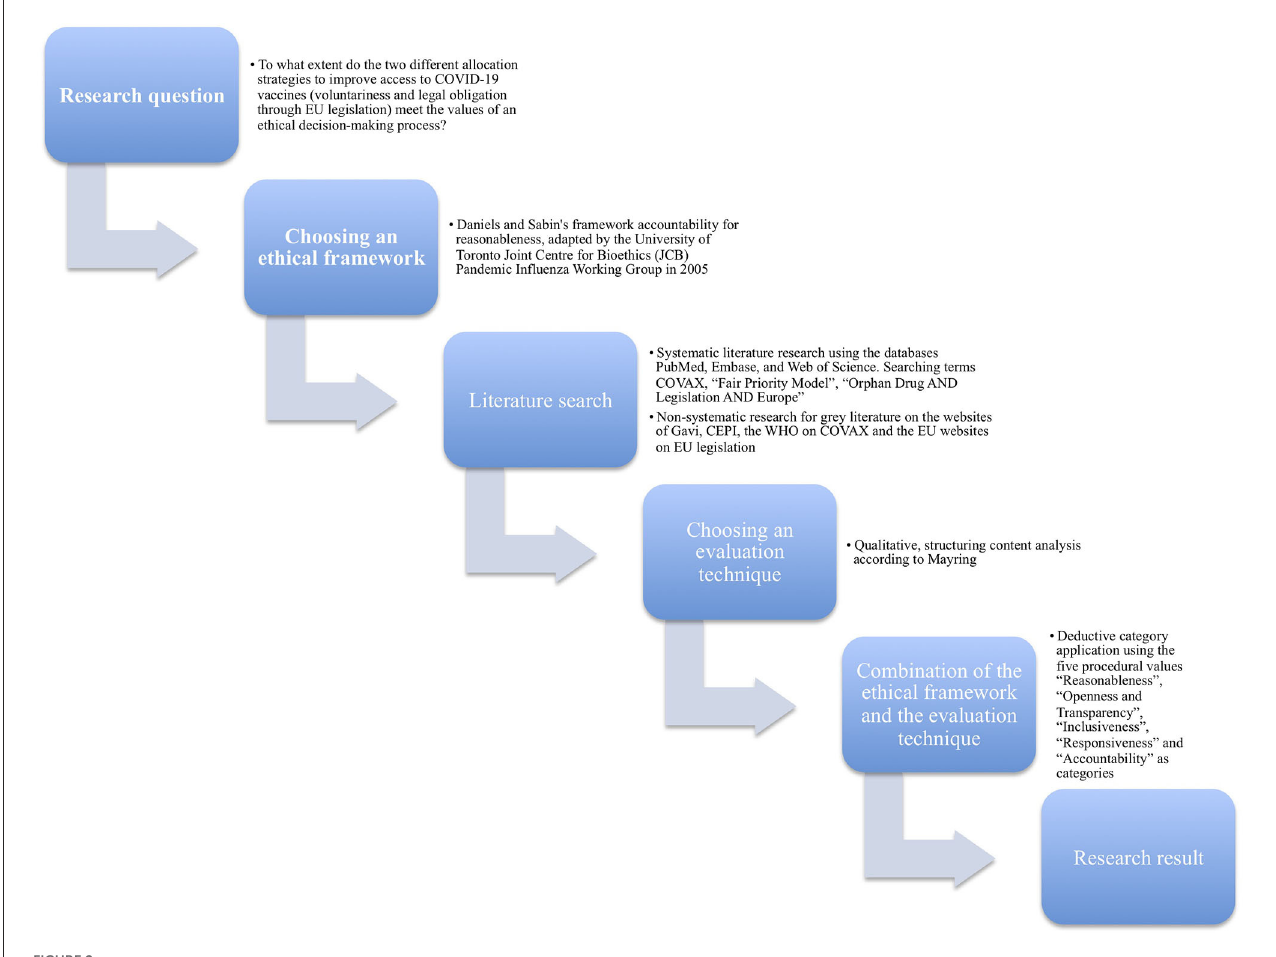
FIGURE2 Graphical representation of the applied